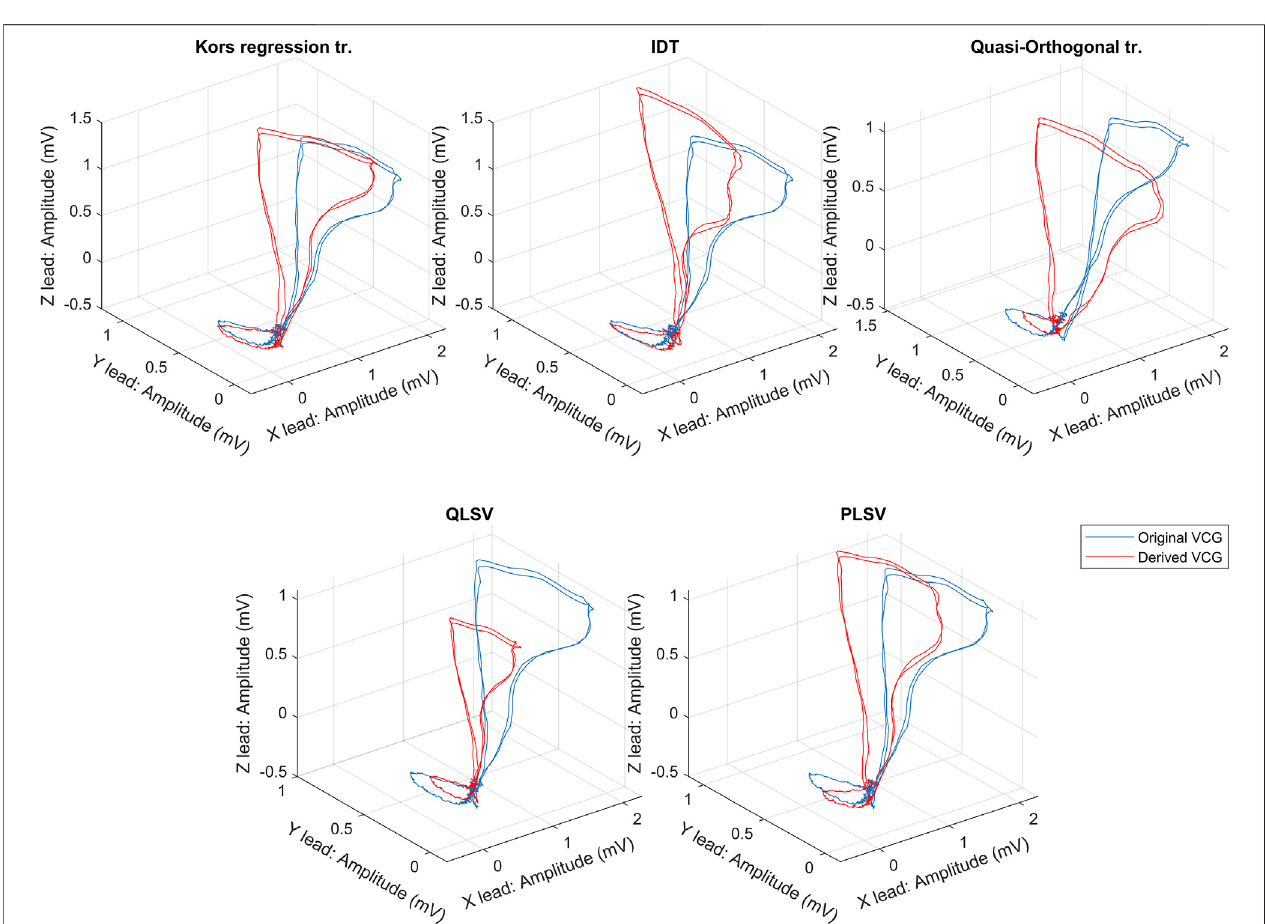
FIGURE 3 | An exemplary comparison of transformation methods, where the blue curve is measured by the Frank lead system and the red curves are the transformed one.